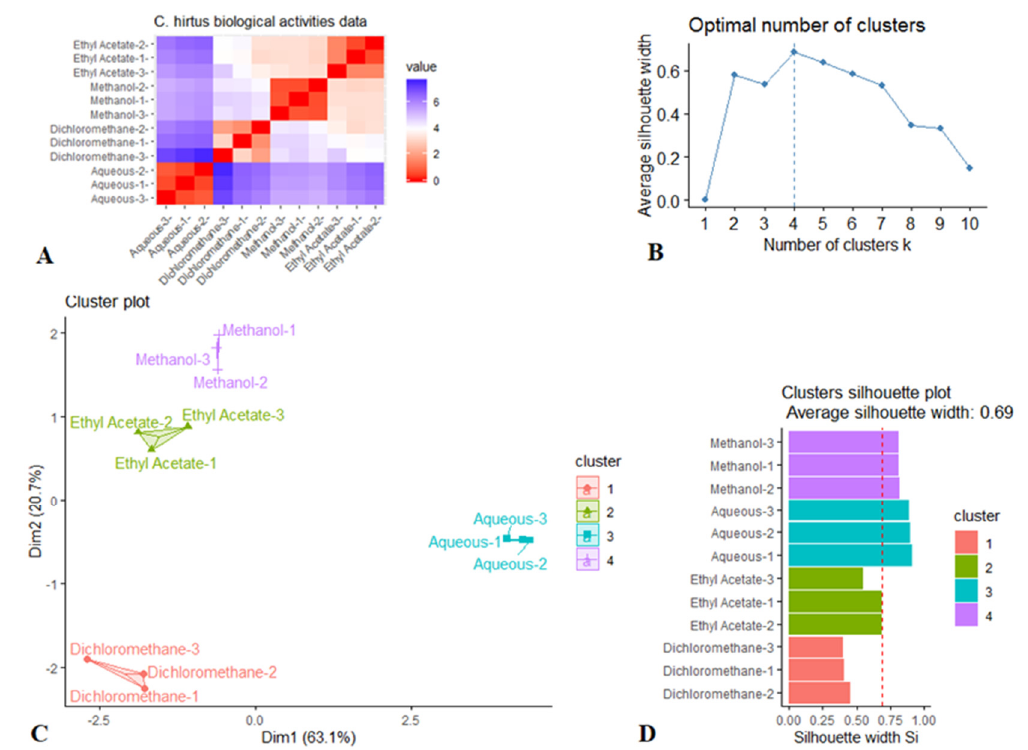
Figure 9. A k -medoids clustering analysis of biological activities of C. hirtus. ( A ) Distance matrix showing the dissimilarity between each pair of subjects (Red color: high similarity, Blue color: low similarity). ( B ) Number of clusters. ( C ) Scatter plot. ( D ) Silhouette plot displaying the average distance between clusters.